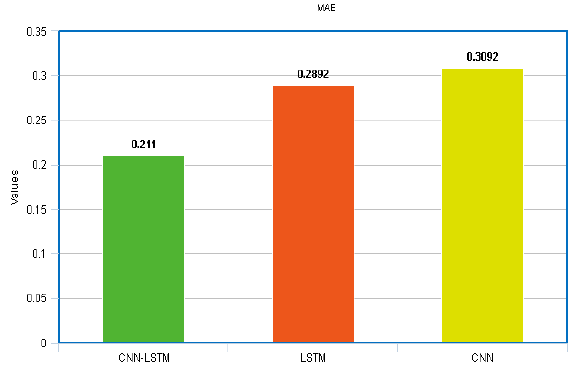
Figure 14. MAE comparison on BHARTIARTL